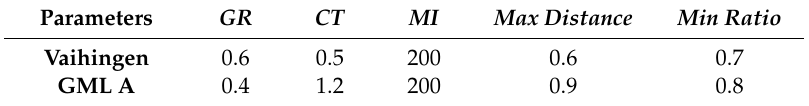
Table 5. The Parameters setting of Algorithm 1 for Vaihingen Dataset and GML Dataset A. Parameters